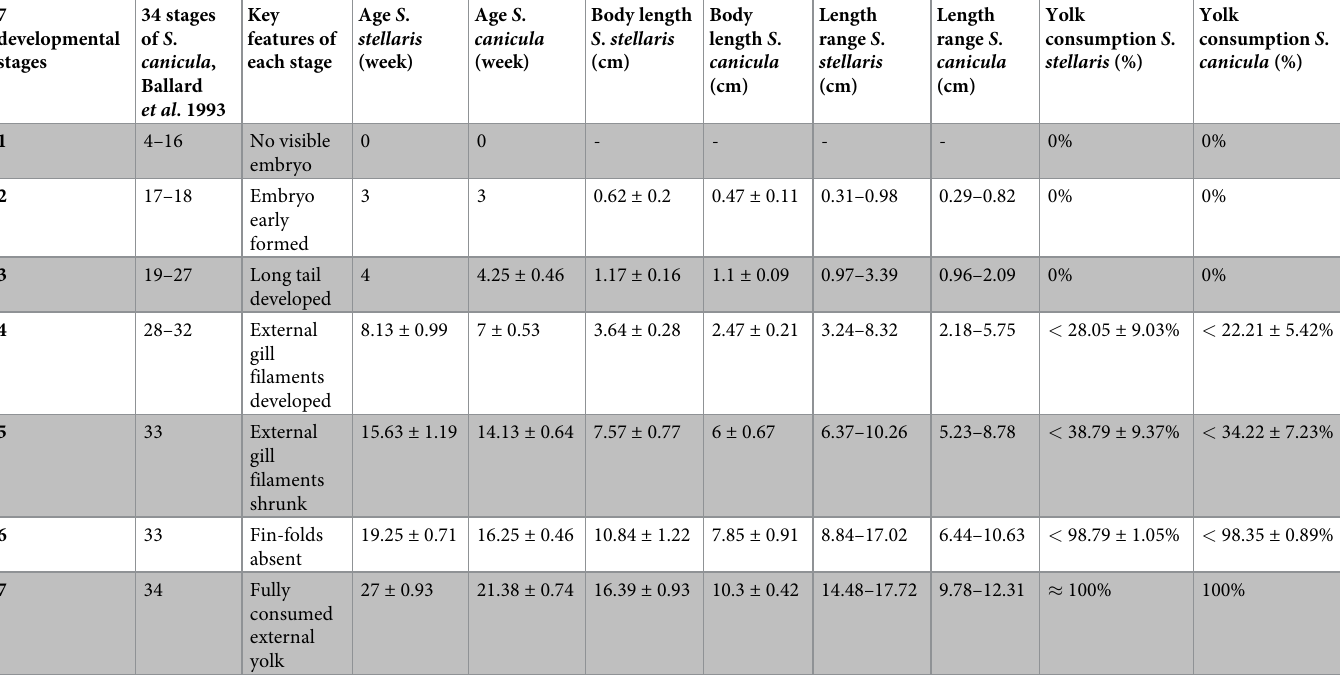
Table 1. Comparison of 7 developmental stages inside the egg case from S . stellaris and S . canicula .